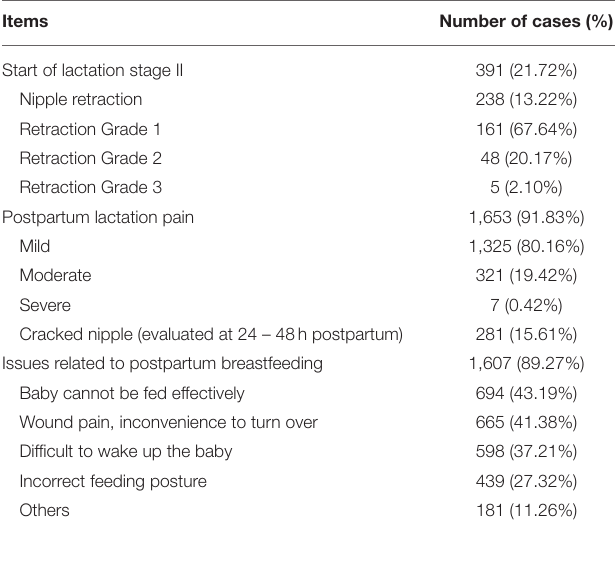
TABLE 2 | The postpartum lactation of mothers ( n %).